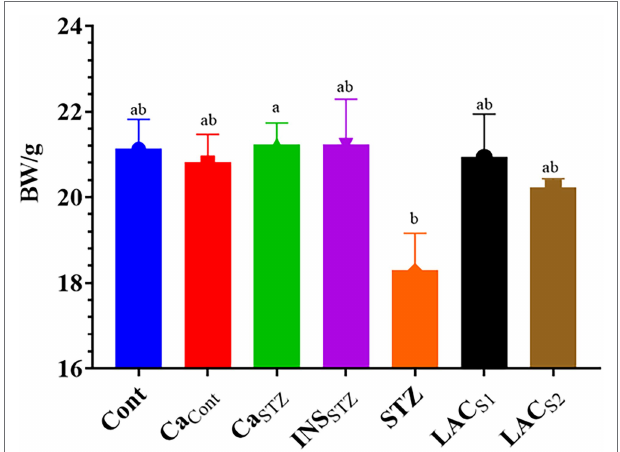
FIGURE 2 | Average of bodyweight/g during 4 weeks. Cont , control; Ca Cont , camel milk control; Ca STZ , camel milk with streptozotocin; INS STZ , insulin with streptozotocin; STZ , streptozotocin; LAC SI , KLDS 1.0727 with streptozotocin; LAC S2 , KLDS 1.0373 with streptozotocin. Result are given in triplicate as mean ± SD. Different letters indicate significant differences among groups ( p <